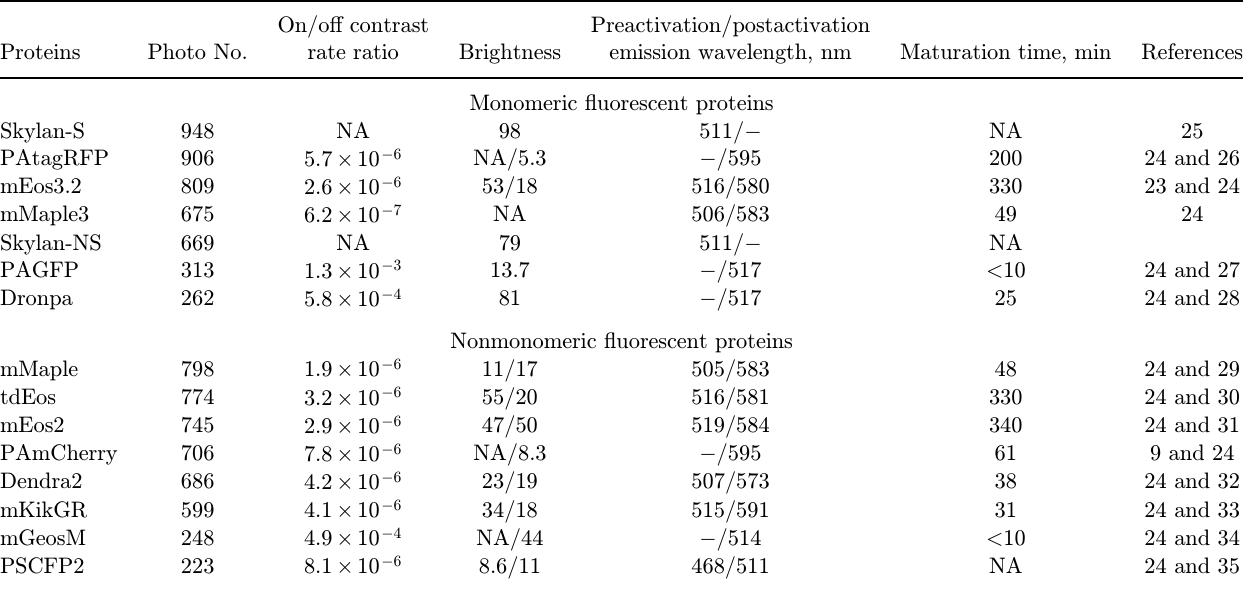
Table 1. Characteristics of photomodulatable °uorescent